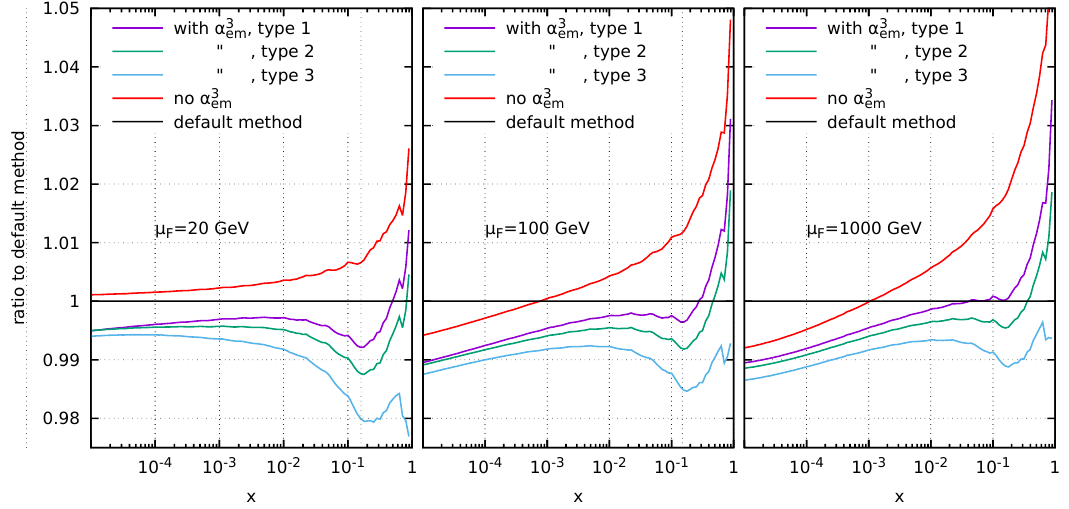
Figure 14. Comparison of the di(cid:11)erent methods to include the e(cid:11)ects of order (cid:11) 3 , see text for more